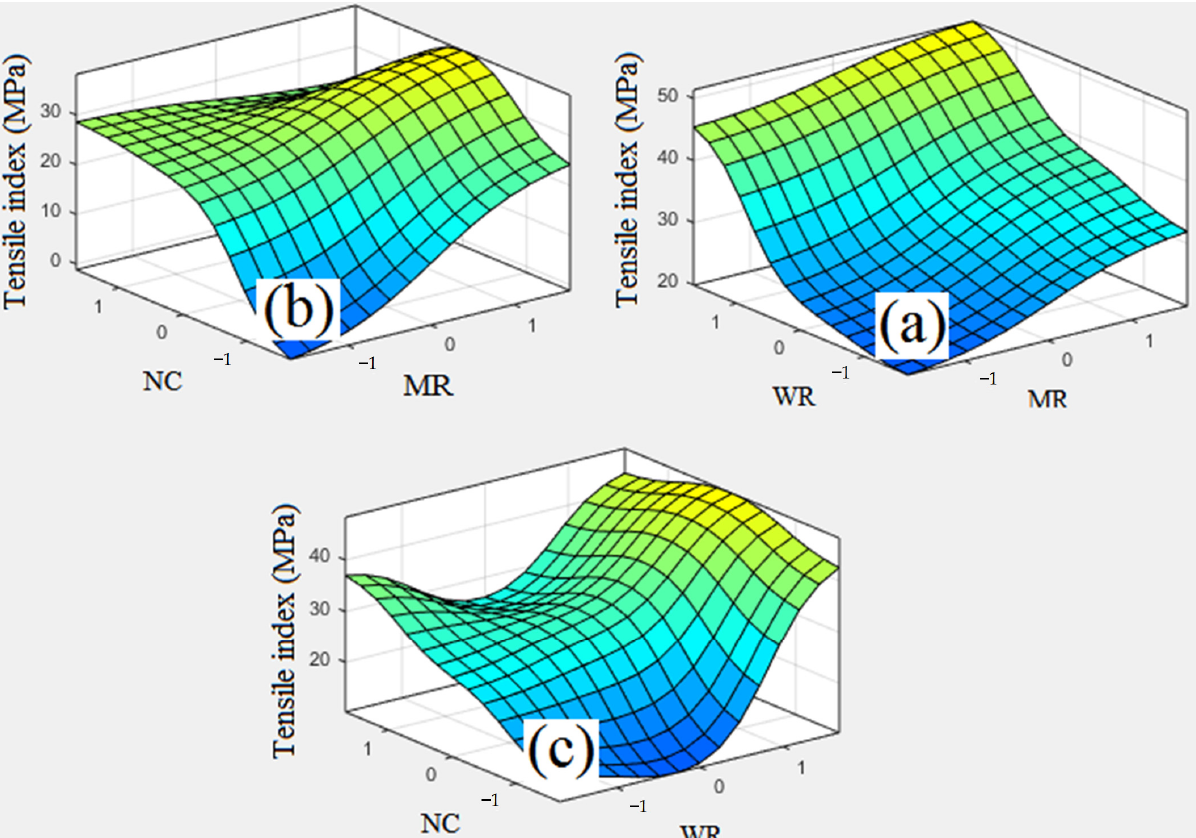
Figure 8. The interaction of the molar ratio× weight ratio ( a ), molar ratio× nano percentage ( b ), and weight ratio× nano percentage ( c ) on the tensile index.